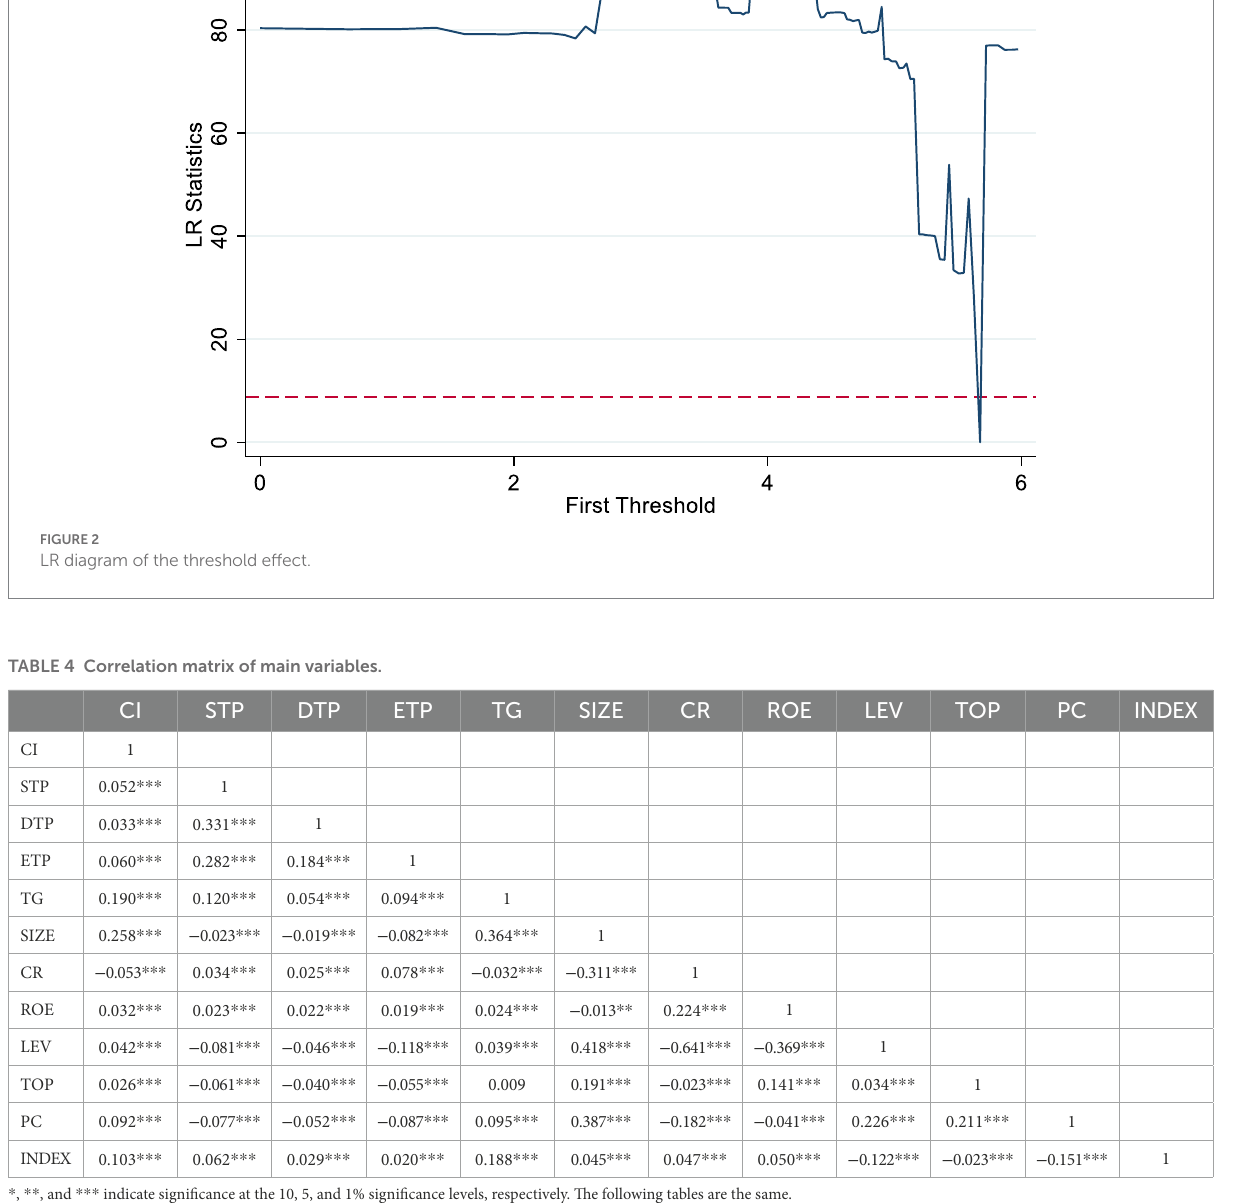
* , ** , and *** indicate significance at the 10, 5, and 1% significance levels, respectively. The following tables are the same.